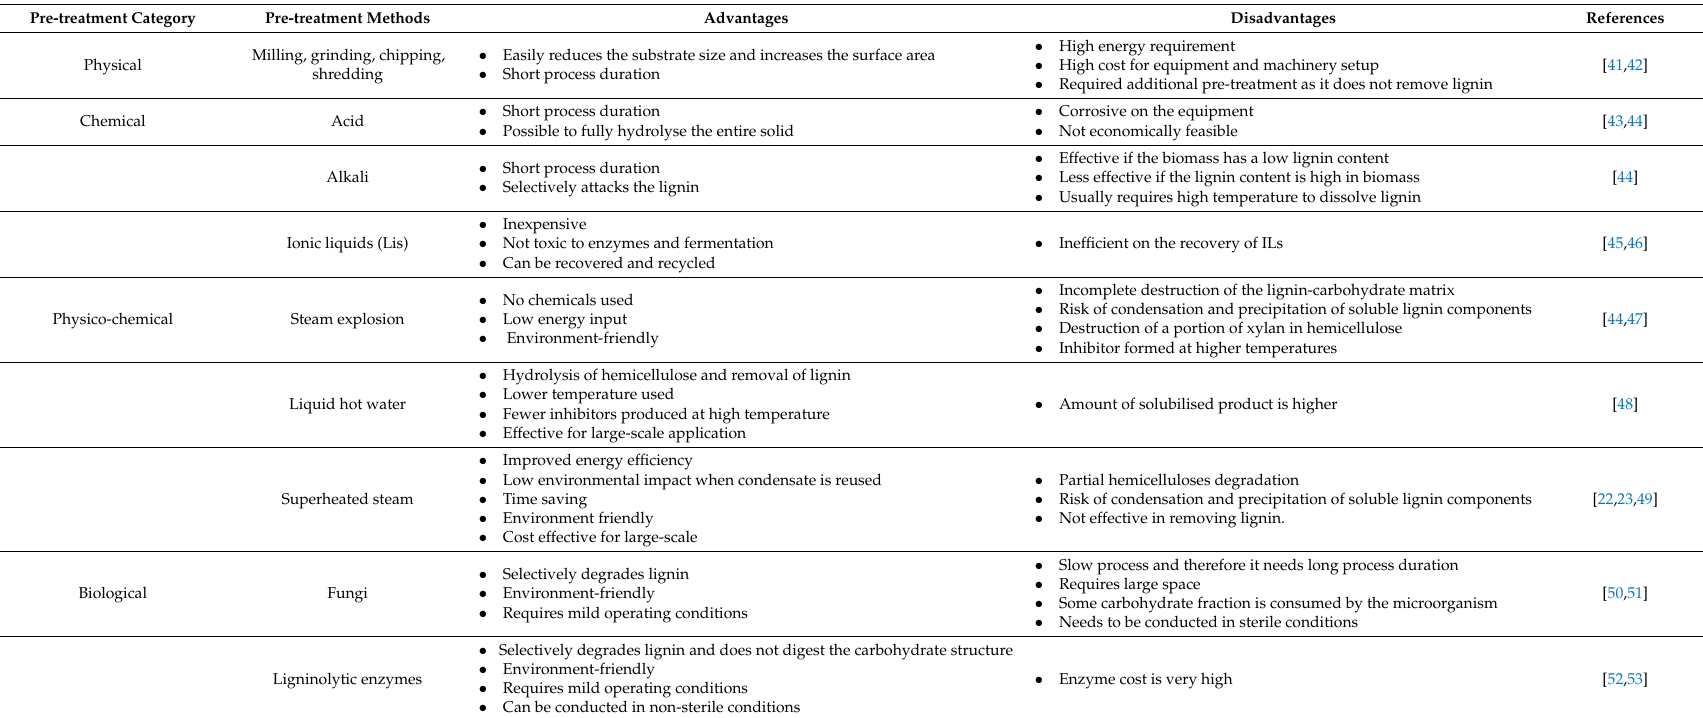
Table 2. Advantages and disadvantages of various pre-treatment